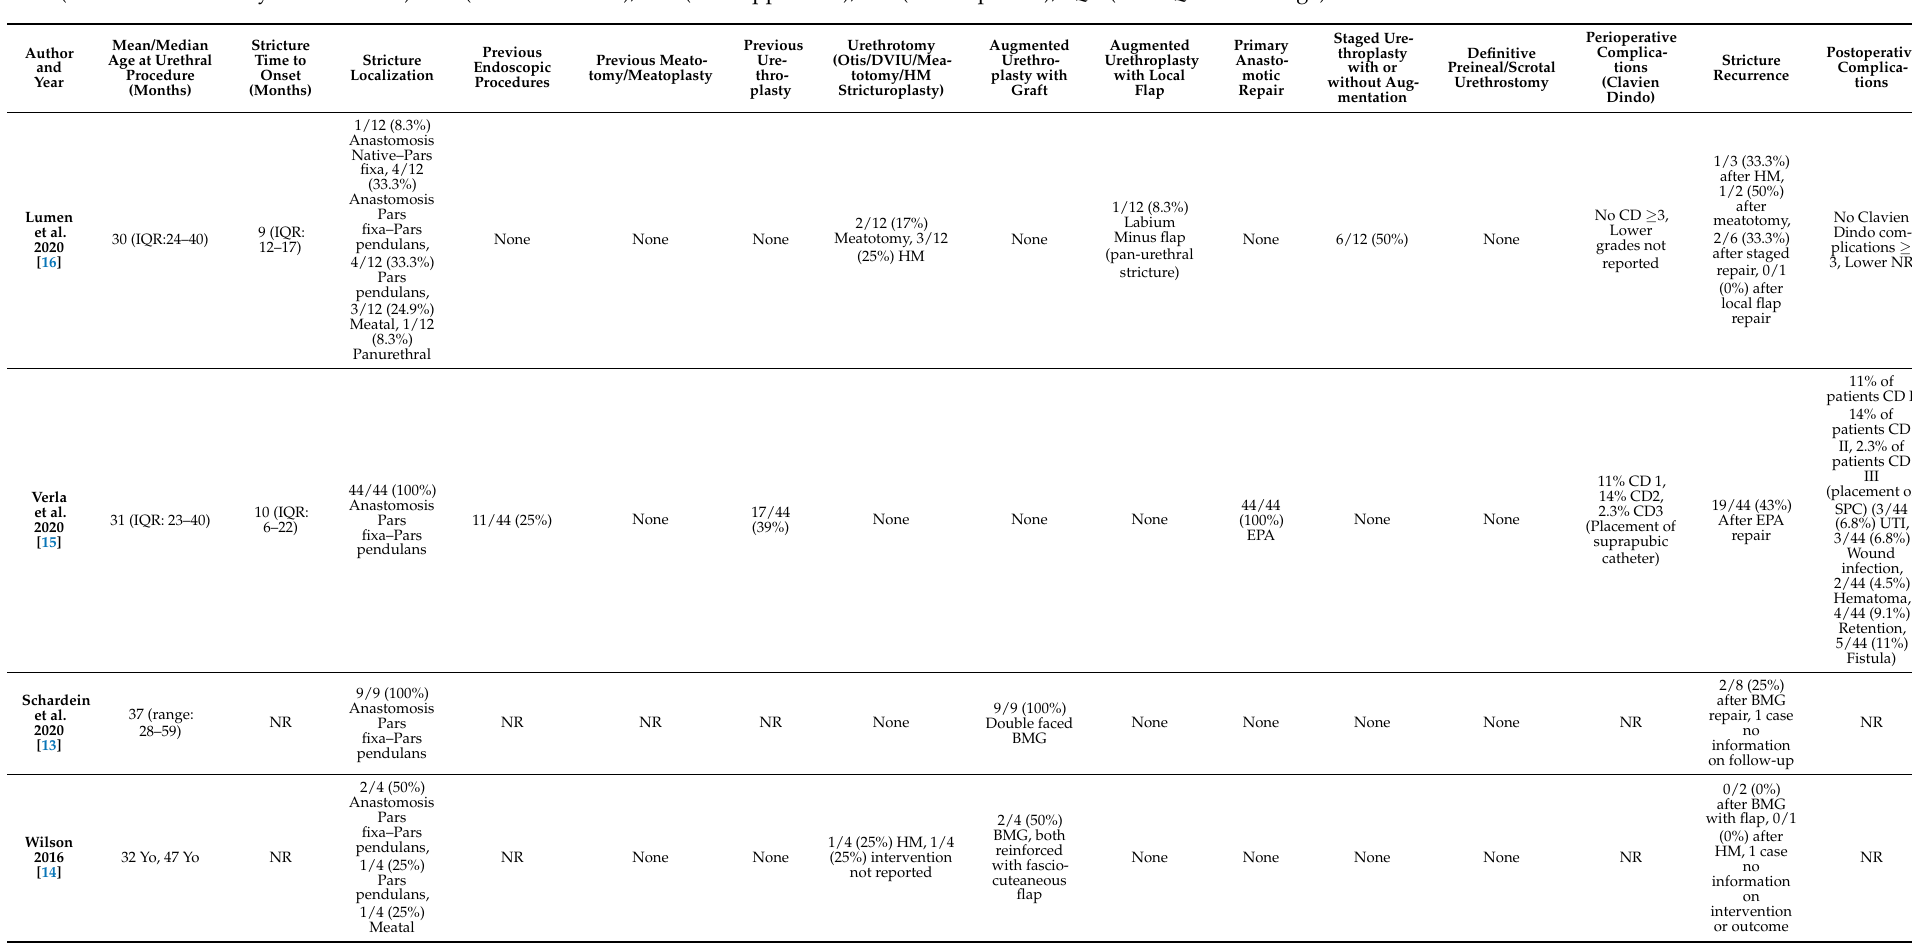
Table 2. Intervention and outcomes of included studies. DVIU (Direct Vision Internal Urethrotomy), HM (Heineke Miculicz), BMG (Buccal Mucosal Graft). CD (Clavien-Dindo), EPA (Exision and Primary Anastomosis) FtM (Female to Male), NA (Not Applicable), NR (Not Reported), IQR (Inter Quartile